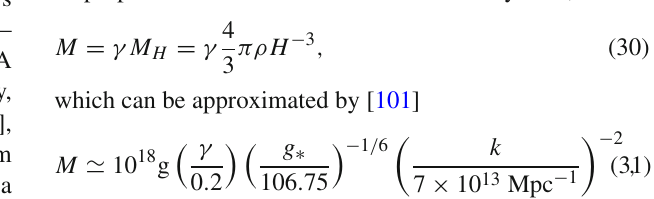
frequency f in Fig. 5,